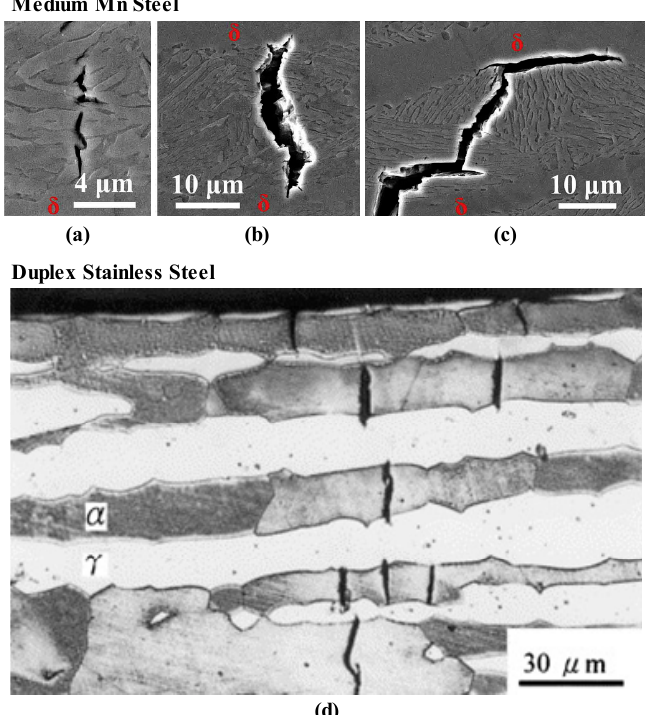
Figure 12. Comparison of H-induced cracks that formed in ( a – c ) an intercritically annealed medium–Mn steel and ( d ) a 2205 duplex stainless steel, both tensile–tested during electrochemical H charging. Reproduced from References [49,61], with permission from Elsevier.